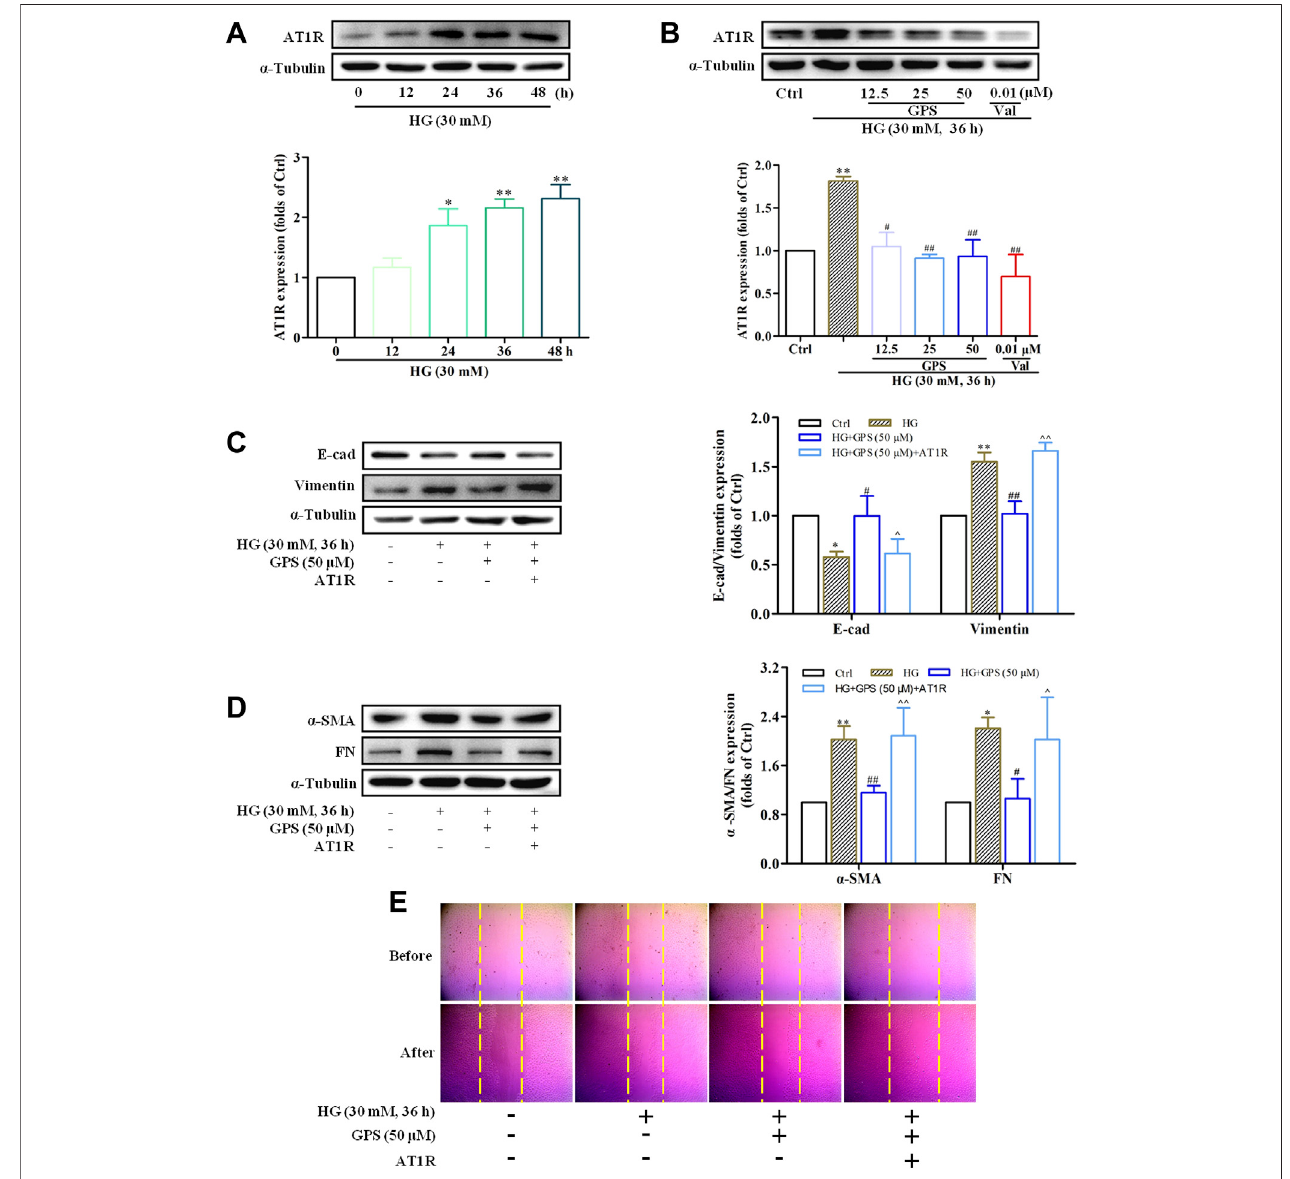
FIGURE 7 | GPS downregulated the protein level of AT1R, and AT1R over-expression reversed the effect of GPS on EMT in HG-induced NRK-52E cells. (A) Expressions of AT1R under the HG conditions at various times were detected by Western blot. ** p < 0.01 and * p < 0.05 vs . 0 h. (B) Protein level of AT1R after GPS interventionwasdetectedbyWesternblot.** p < 0.01 vs .Ctrl. ## p < 0.01and # p < 0.05 vs .HG. (C,D) EffectsofGPSonE-cad,vimentin, α -SMA,andFNexpressionafter AT1R over-expression were detected by Western blot. ** p < 0.01 vs . Ctrl. ## p < 0.01 and # p < 0.05 vs . HG. ^^ p < 0.05 vs . HG with GPS. (E) Effect of GPS on the migration ability after the AT1R over-expression was detected by the cell scratch test. Data were expressed as mean ± SD.